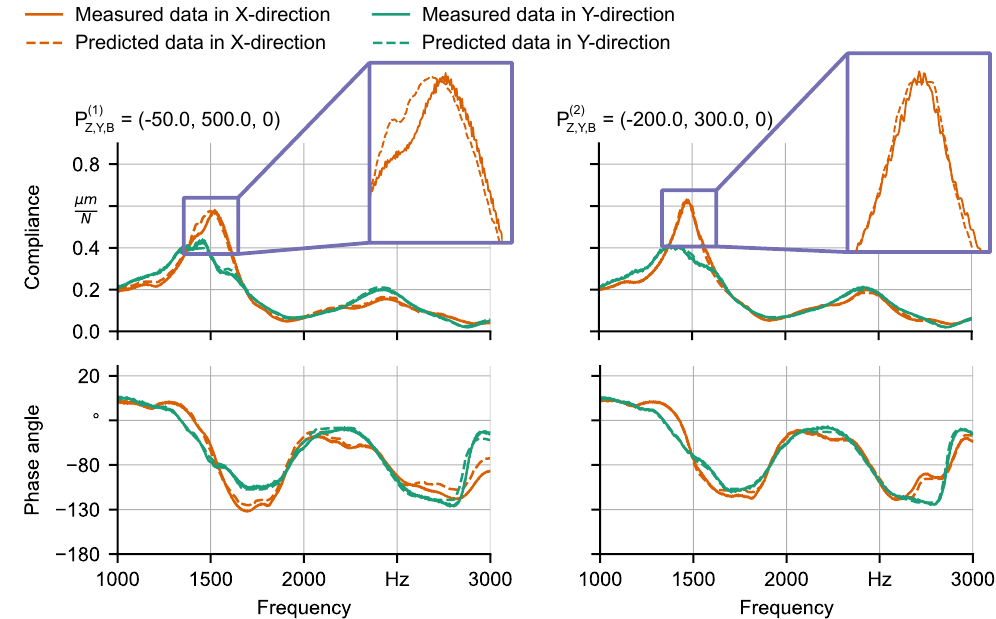
Figure 6. Predicted and measured FRFs for four different pose configurations using machine tool M 2